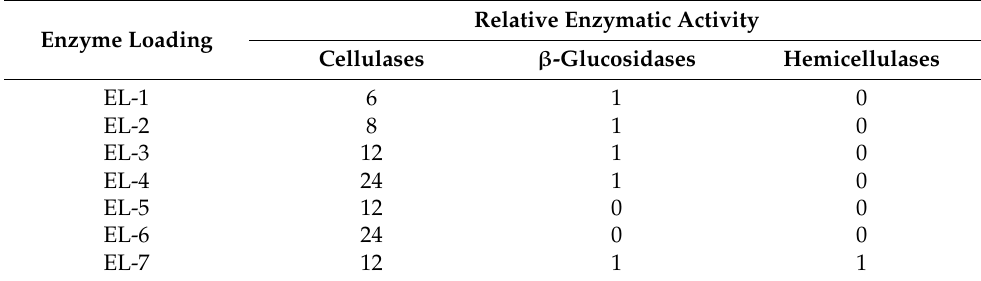
Table 1. Relative enzymatic activities * assayed for enzymatic hydrolysis. Relative Enzymatic Activity Enzyme Loading Cellulases β -Glucosidases